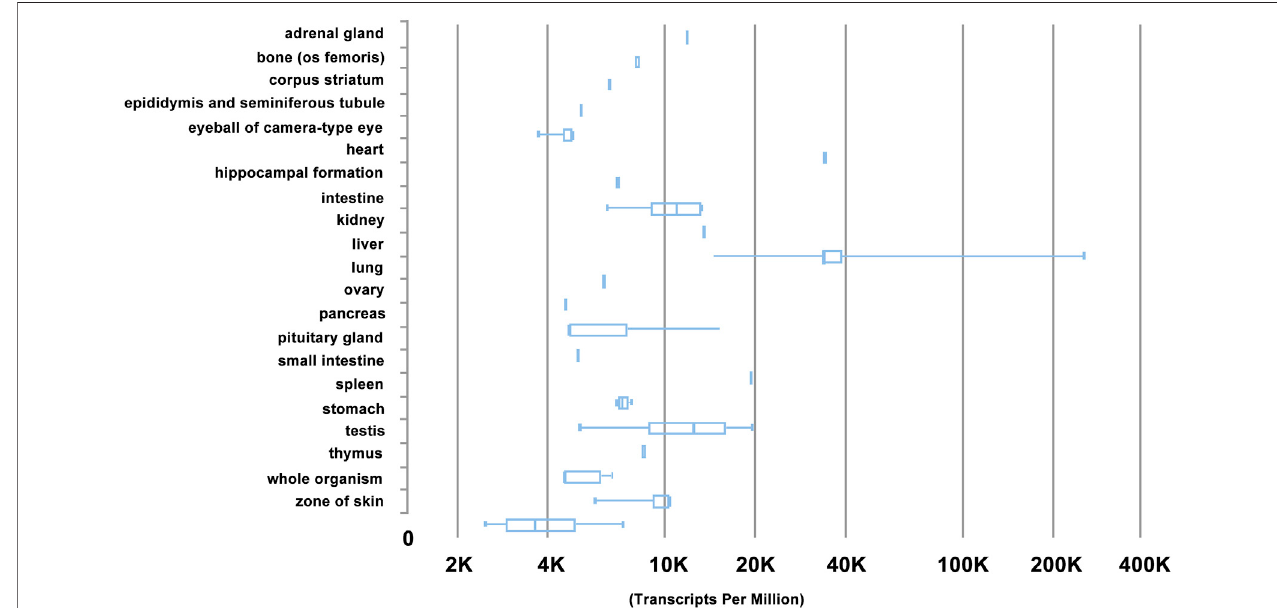
FIGURE5| Geneexpressionpro fi leofHNbyRNA-SeqCAGE(CapAnalysisofGeneExpression)analysisofmousecellsinRIKENFANTOM5project.NotethatHN is most abundantly in mouse cell types of hepatocytes, adipocytes, and enterocytes, based on https://www.ebi.ac.uk/gxa/experiments/.